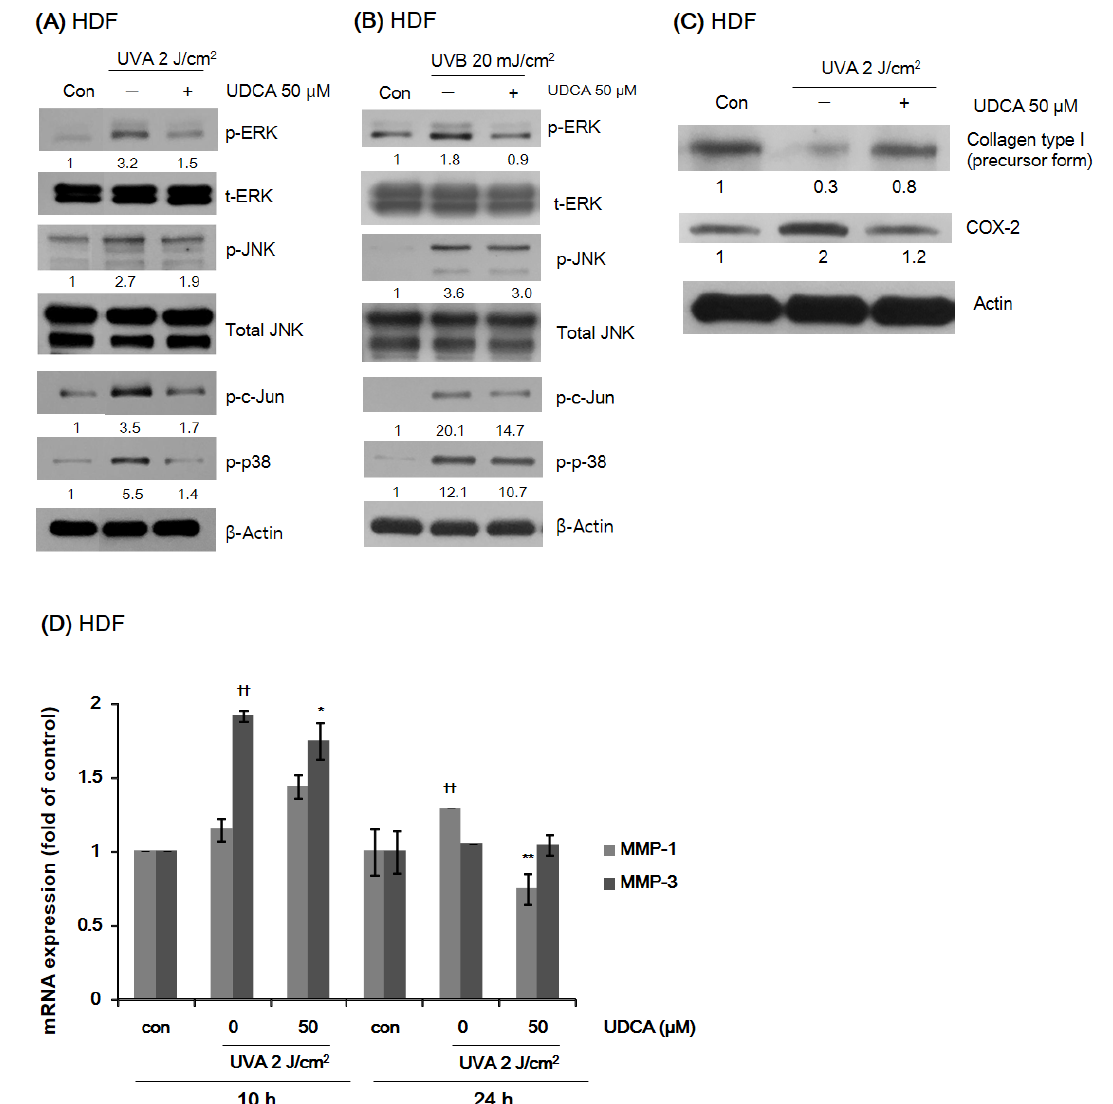
Figure 3. Effect of UDCA treatment on the expression of phosphorylated proteins related to environmental aging-associated inflammation following exposure to ( A ) UVA and ( B ) UVB in HDFs. For both spectrums of UV radiation, treatment with 50 µ M UDCA resulted in decreased expression of p-ERK, p-JNK, p-c-Jun, and p-p-38. ( C ) Changes in expression levels of type 1 collagen and COX-2, as a senescence-associated secretory phenotype, after exposure to UVA, and the effect of UDCA treatment. Treatment with 50 µ M UDCA increased the expression of type I collagen, while it decreased the expression of COX-2. ( D ) Inhibitory effect of UDCA on MMP-1 and MMP-3 expression induced by UVA in HDFs. * p < 0.05 and ** p < 0.01 compared with the UV-exposed control. †† p < 0.01 compared with the null control (con).